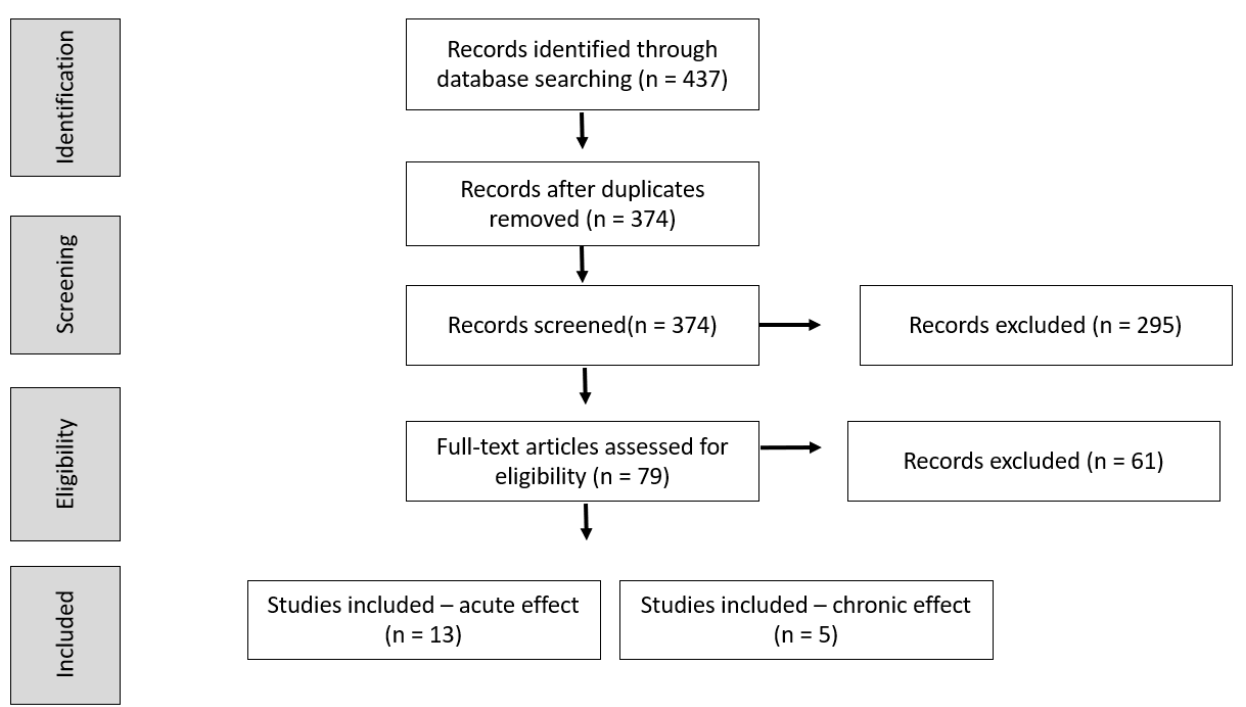
Figure 1. Flowchart of the systematic search for articles.